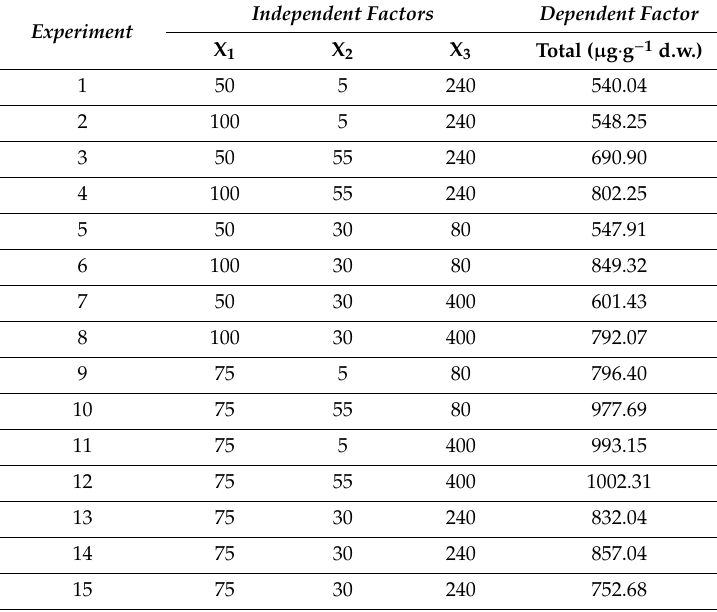
Table 1. Box-Behnken design (BBD) with the values of the sonotrode ultrasound (US) parameters with the experimental values for the dependent response of proanthocyanins (PCs) quantified by HPLC-fluorometric detector (FLD) in brewers’ spent grain (BSG) extracts; d.w.—dry weight. Independent Factors Dependent Factor Experiment